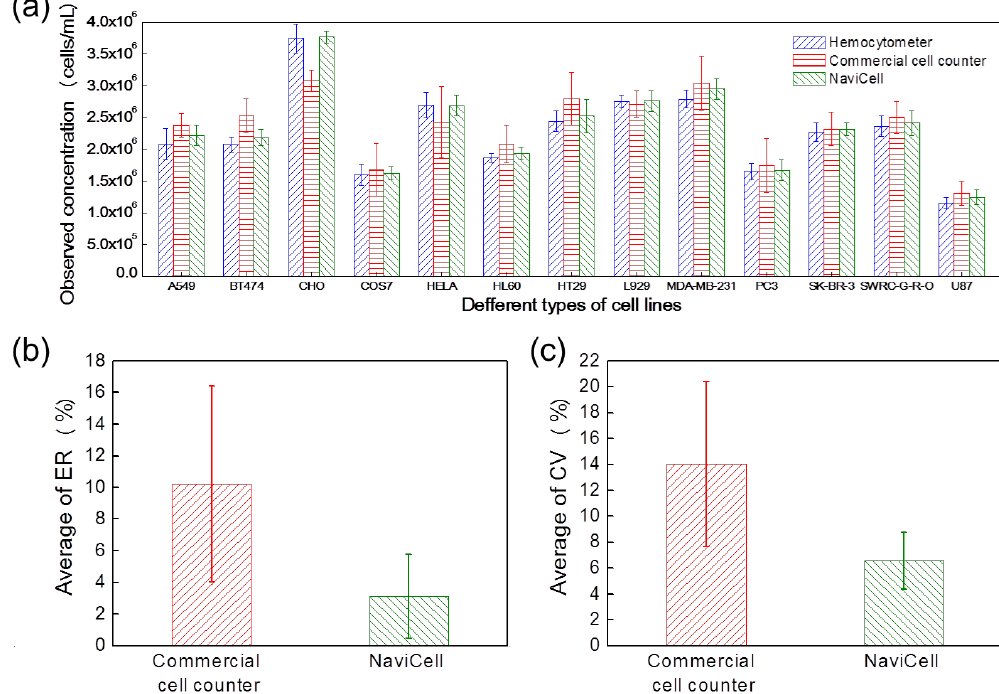
Figure 4. Comparison of cell counting performance using 13 cell lines. ( a ) Cell counting results of the NaviCell and the conventional methods are analyzed for the A549, BT474, CHO, COS7, HELA, HL60, HT29, L929, MDA-MB-231, PC3, SK-BR-3, SWRC-GRO and U87 cell lines. Improved counting precision of the NaviCell is demonstrated in terms of ( b ) average ER values and ( c ) average CV values.